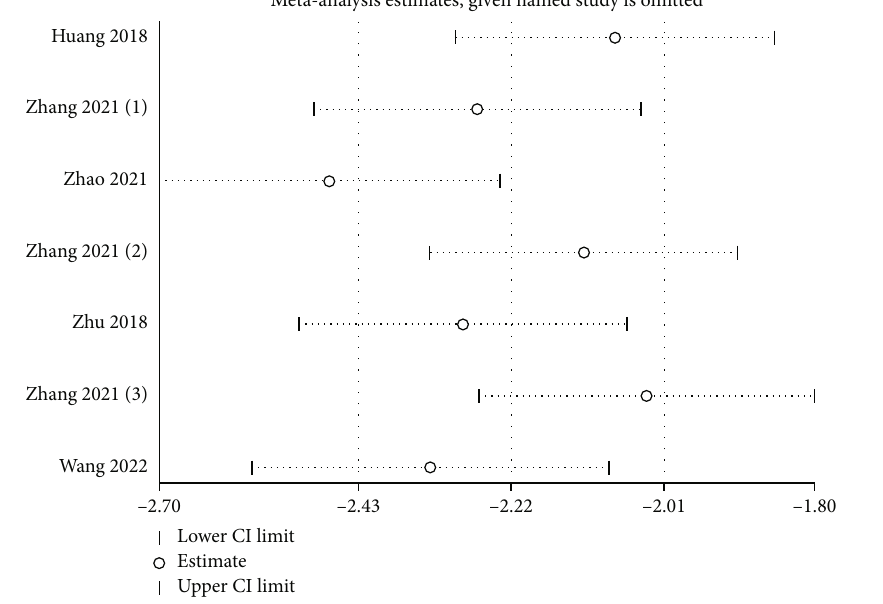
Figure 3: Sensitivity analysis of the serum uric